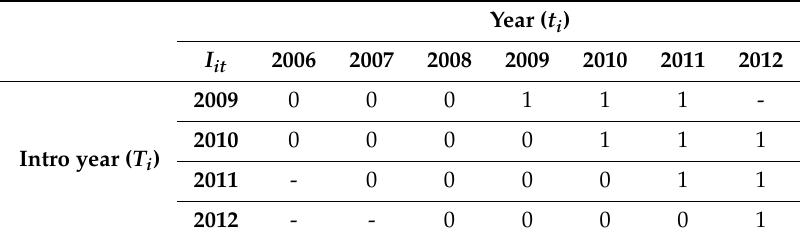
Table 1. Flexible point-of-care testing (POCT) introduction